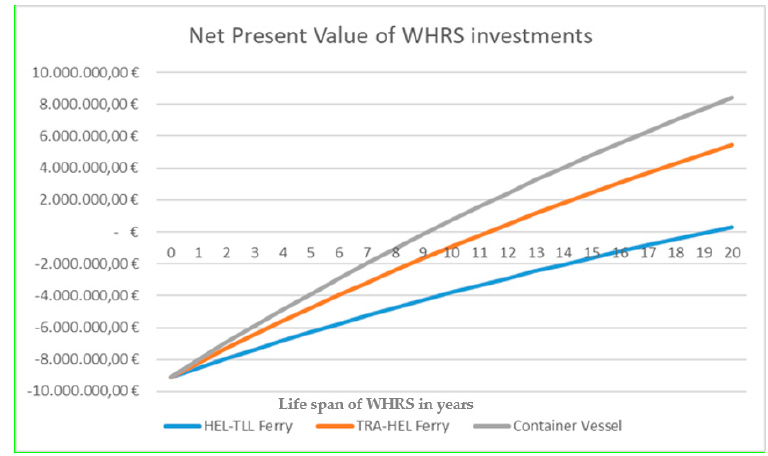
Figure 4. Net present value of WHRS investments on three vessels.